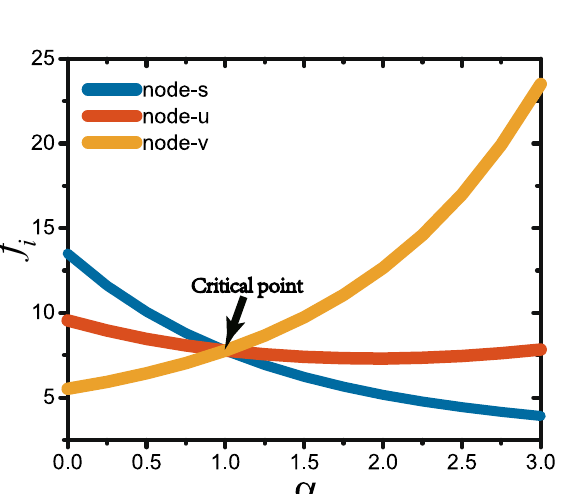
Figure 6. Time series of arbitrarily chosen nodes s , u and v from the random network of p = 1 , where the degrees of the nodes s , u and v are 12, 6 and 2, respectively. ( a – c ) represent the cases of α = 0, 1 and 3, respectively.